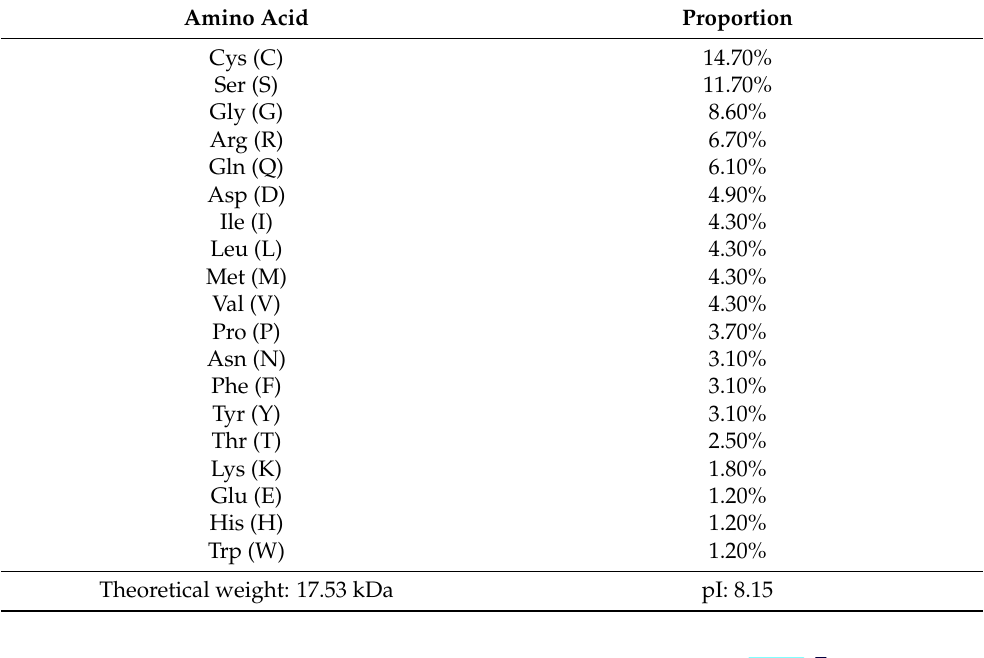
Table 2. Composition of the cysrichin protein.